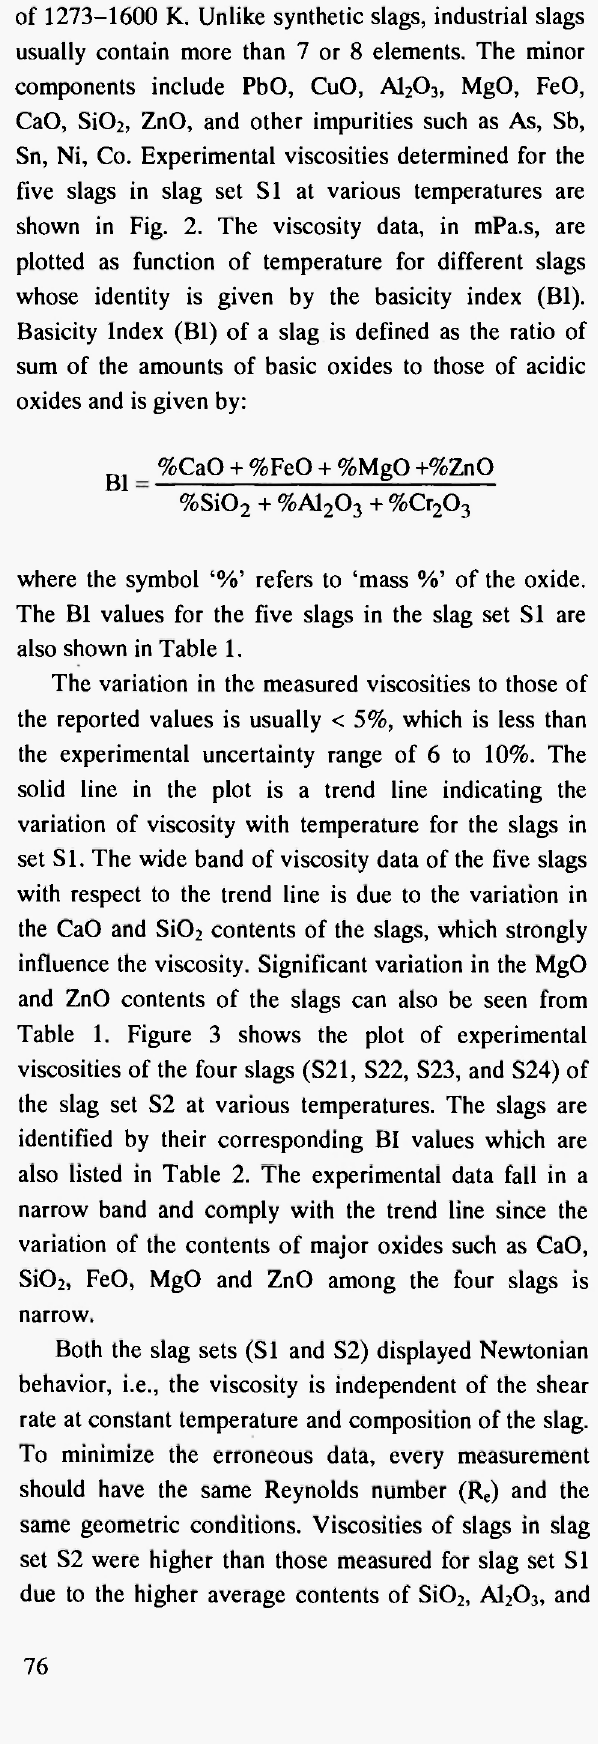
Fig. 2: Viscosities of slags in the Slag set SI as a function of temperature. The various slags are indicated by their bacisity index (BI) values. Solid line indicates the trend.